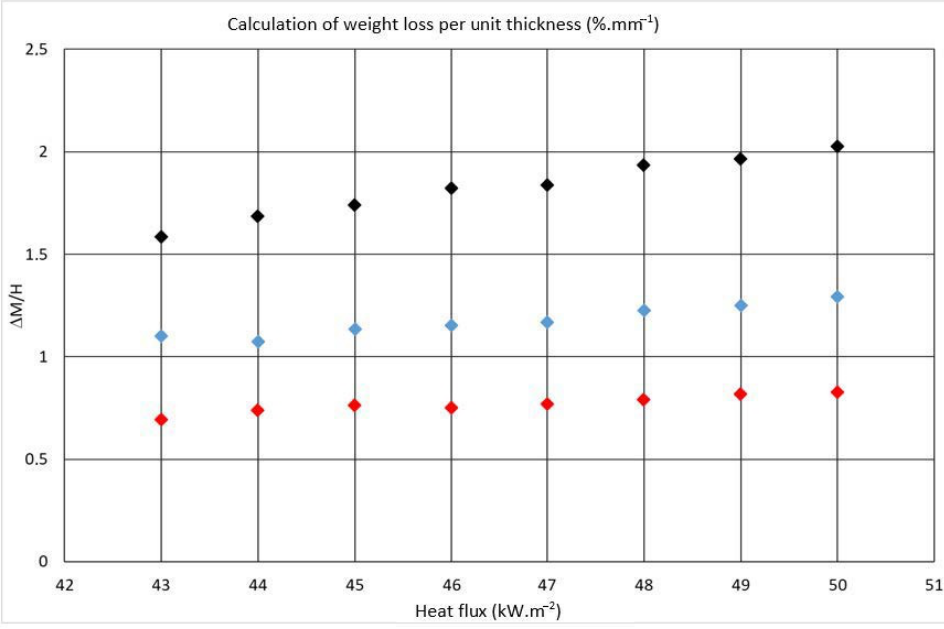
Figure 7. Graphical dependence of the weight loss ∆ M and sample thickness H ratio on the heat flux. Legend: black point, 12 mm thickness; blue point, 15 mm thickness; red point, 18 mm thickness.